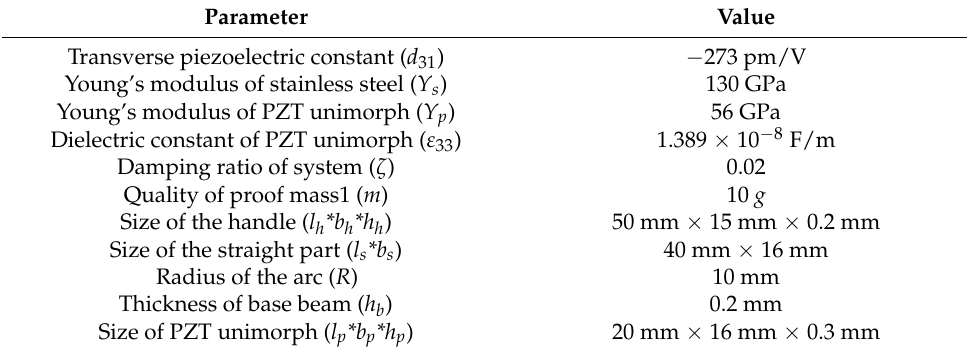
Figure 5. Photograph of the fabricated prototype. Table 1. Material properties and structural parameters of the proposed energy harvester.